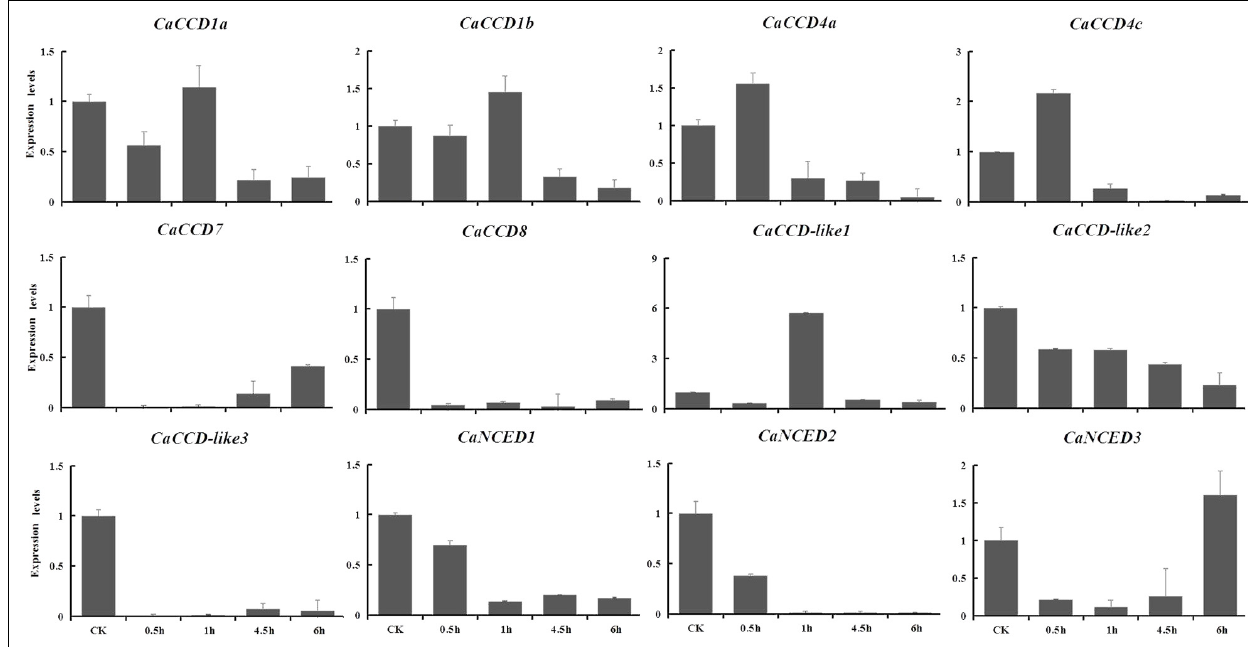
FIGURE 7 | Expression patterns of CaCCO genes in response to heat stress at different time points.